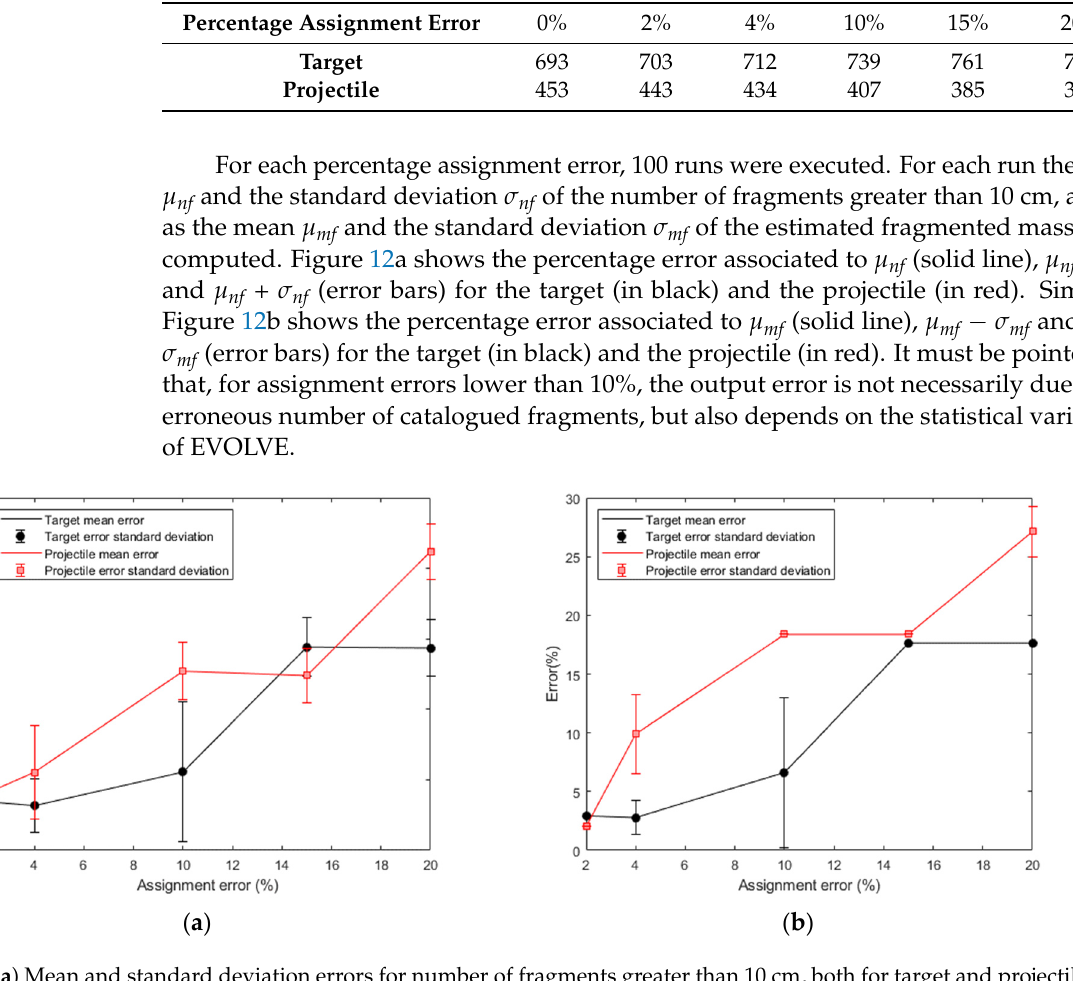
Table 4. Values of N cat for different percentages of assignment error.